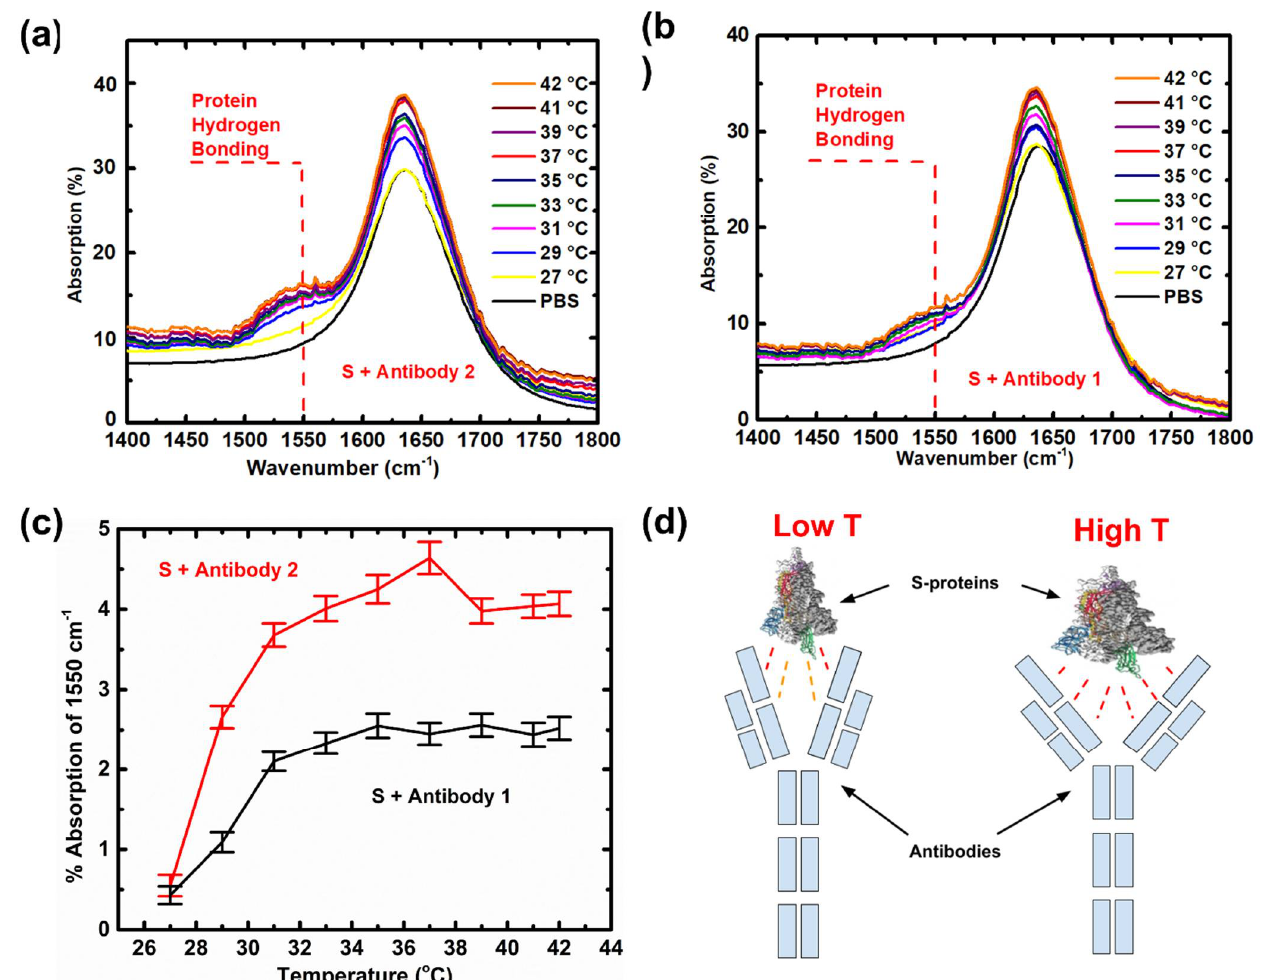
Figure 2. ( a ) Detailed FTIR scan of the sample mixture of SARS-CoV-2 spike protein/SARS-CoV-2 antibody (S + Antibody 2) in PBS solution, within the wavenumber range of 1400–1800 cm − 1 . ( b ) Detailed FTIR scan of the sample mixture of SARS- CoV-2 spike protein/SARS-CoV-1 antibody (S + Antibody 1) in PBS solution, in the wavenumber range of 1400–1800 cm − 1 . ( c ) The infrared absorptions of 1550 cm − 1 under variable temperature of the sample combination of SARS-CoV-2 spike protein/SARS-CoV-2 antibody versus the sample combination of SARS-CoV-2 spike protein/SARS-CoV-1 antibody, ob-